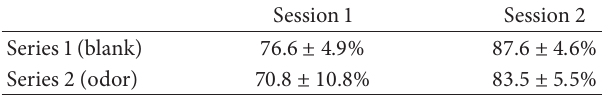
Table 5: Grooming events comprised in sequences (in percents to all grooming events, mean ± standard error).